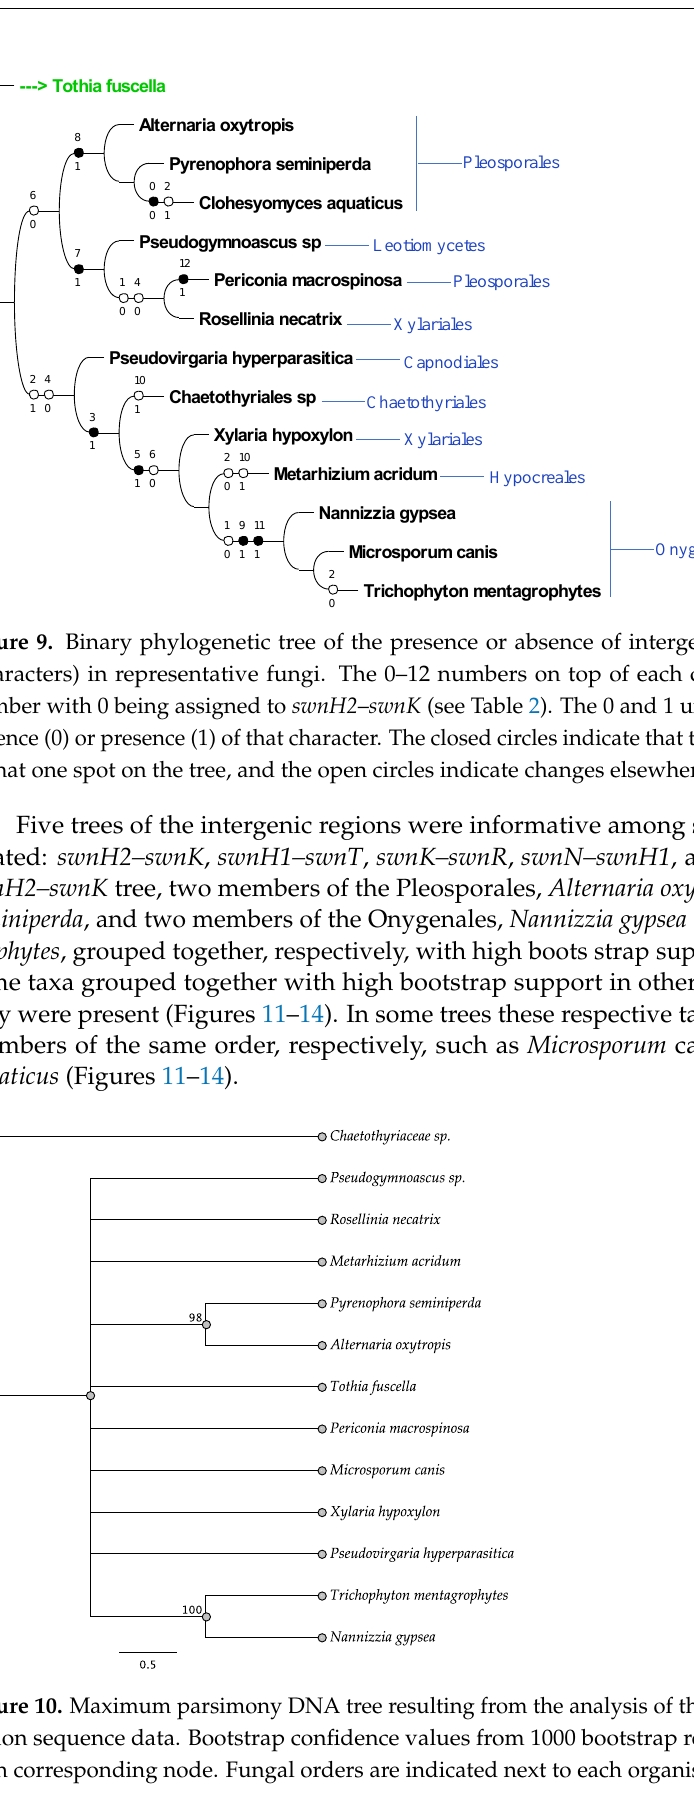
Figure 11. Maximum parsimony DNA tree resulting from the analysis of the swnH1 – swnT intergenic region sequence data. Bootstrap confidence values from 1000 bootstrap replicates are presented at each corresponding node. Fungal orders are indicated next to each organism/clade.